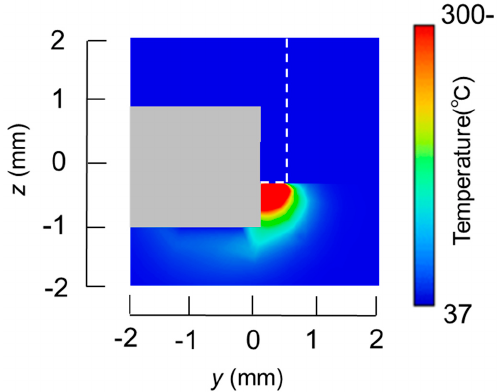
Figure 6. Temperature distributions of the microwave snare at z = − 0.3 mm.